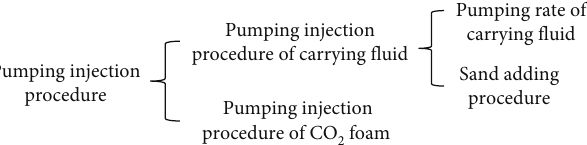
Figure 5: The relationship between pump rate and friction of CO foamed fracturing (60%).